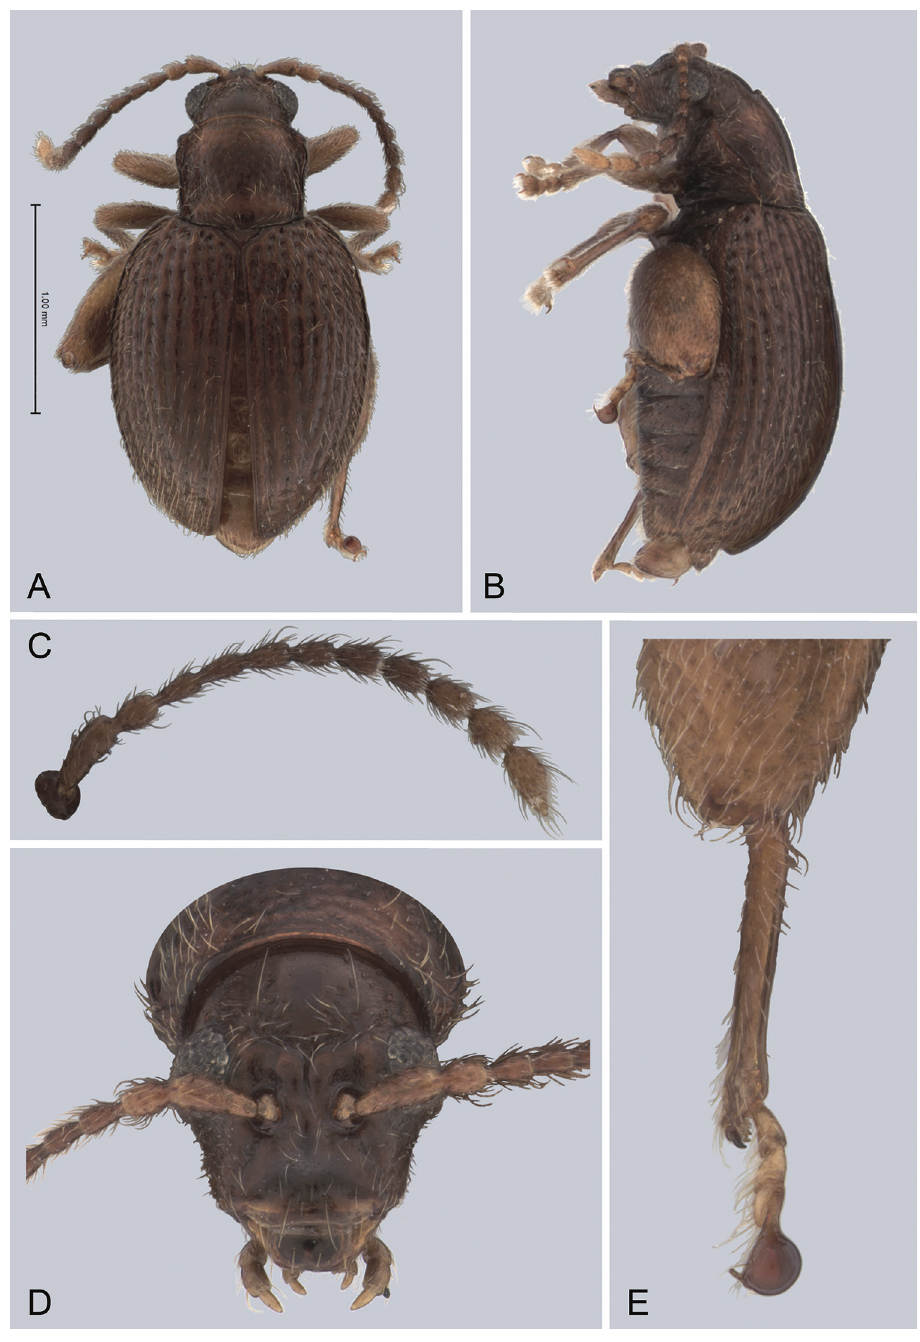
Figure 30. Andersonoplatus rosalesi . A Habitus dorsal B Habitus lateral C Antenna D Head, frontal view E Hind